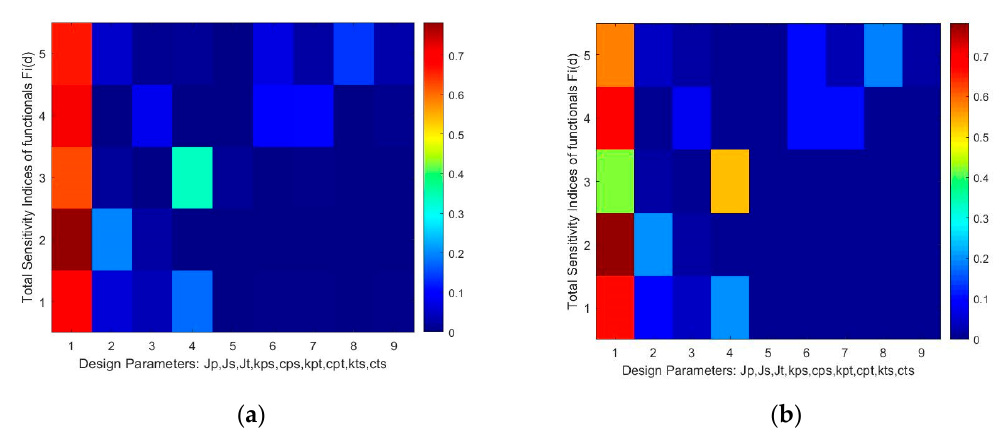
Figure 2. Sensitivity indices of the objective functions (8)–(10) for the drivetrain equipped with the psptsTMF: ( a ) for T m = 300 Nm, a e = 500 Nm ; ( b ) for T m = 3000 Nm, a e = 3000 Nm